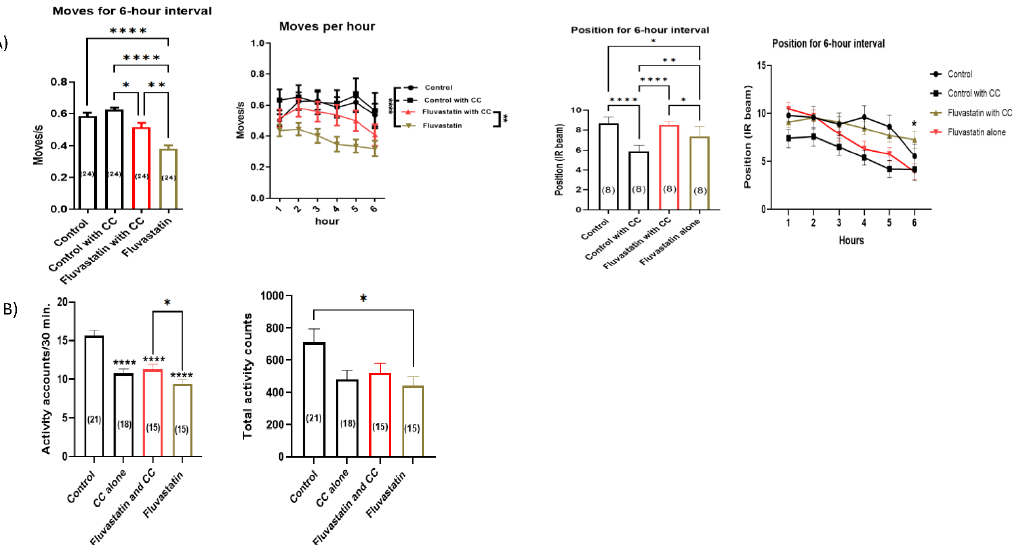
Figure 8. Chelerythrine chloride, CC, partially but significantly rescued the fluvastatin-induced lowered activity counts and climbing ability. Male virgin CSORC flies were used for the experi- ments. ( A ) The left histograms show the average moves for six-hour intervals and the moves/s per hour while the right histograms show the same for the average position. In the control group, flies